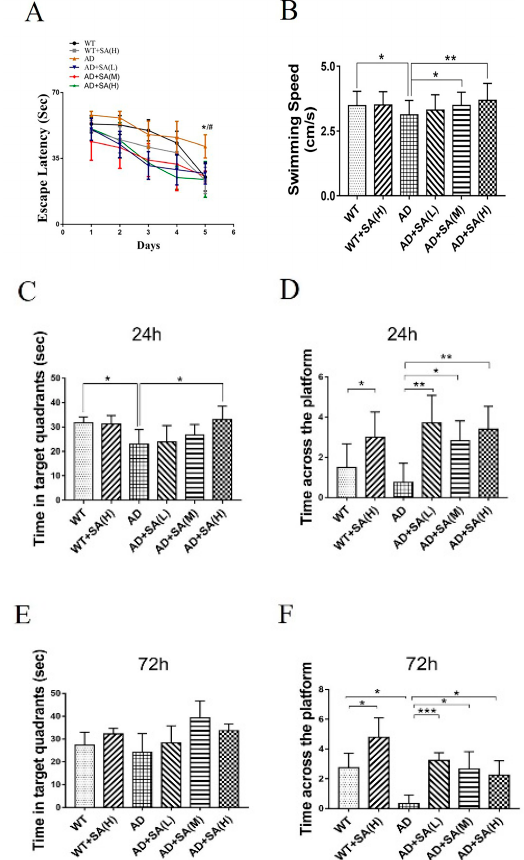
Figure 1. Effect of SA treatment for 4 months on spatial memory and learning ability in 2 × Tg AD mice. ( A ) Escape latency. ( B ) Average swimming speed. ( C ) Time in target quadrant 24 h after 5-day training. ( D ) Times crossing platform 24 h after 5-day training. ( E ) Time in target quadrant 72 h after 5-day training. ( F ) Times crossing platform 72 h after 5-day training (# p < 0.05, * p < 0.05, ** p < 0.01, and *** p < 0.001). Student’s t test was used for statistical analysis. Error bars represent the mean ± SEM ( n =